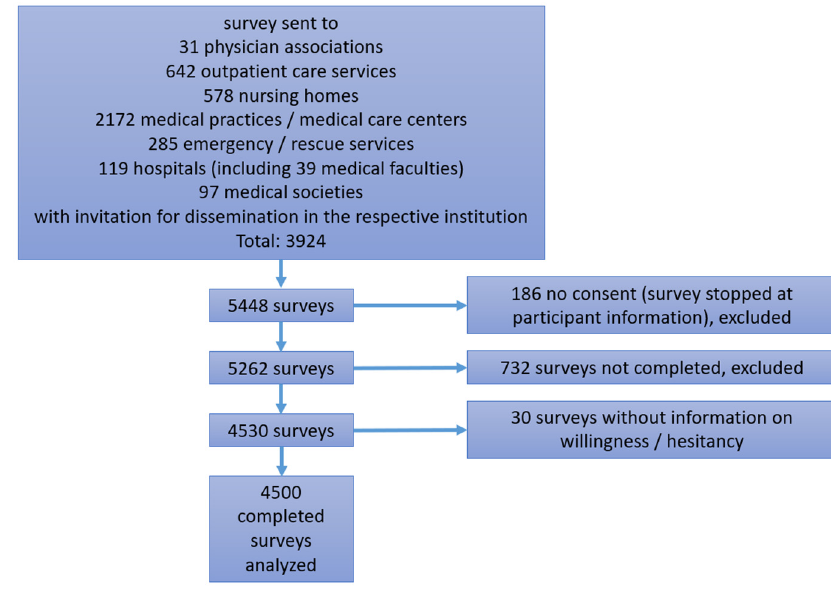
Figure 1. Flowchart of participants.